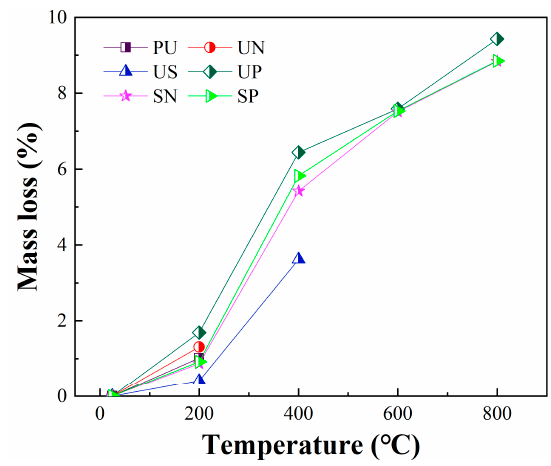
Figure 6. M as s loss after exposure to high temperatures. Figure 6. Mass loss after exposure to high